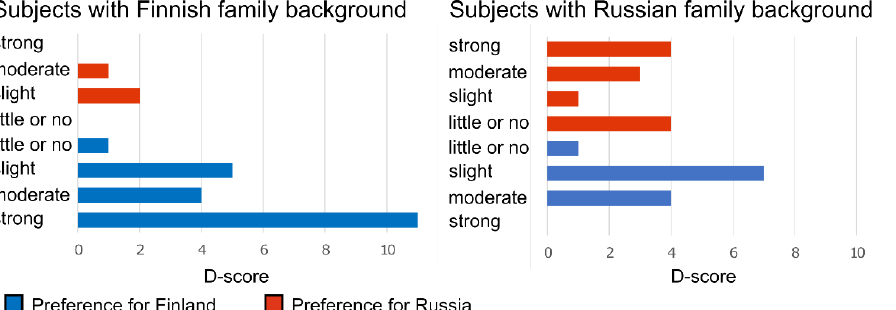
Figure A1. Participants’ preferences for Finland and Russia obtained from IAT. Bar graphs present the number of the participants with each preference level. D-score threshold values were as follows: ≤−0.65: strong preference for Russia over Finland, >−0.65 and ≤−0.35: moderate preference for Russia over Finland, >−0.35 and ≤−0.15: slight preference for Russia over Finland, >−0.15 and <0.15: little to no preference between Finland and Russia, ≥0.15 and <0.35: slight preference for Finland over Russia ≥0.35 and <0.65: moderate preference for Finland over Russia, ≥0.65 strong preference for Finland over Russia (the same thresholds have been used in, e.g. [36,37]). Wilcoxon test showed that Finnish- background participants preferred Finland over Russia (p<0.001, mean d-score: 0.51, std: 0.44, neg- ative values mean preference for Russia and positive for Finland) whereas the Russian-background participants favored neither country ( p = 0.69, mean d-score: −0.07, std: 0.45).